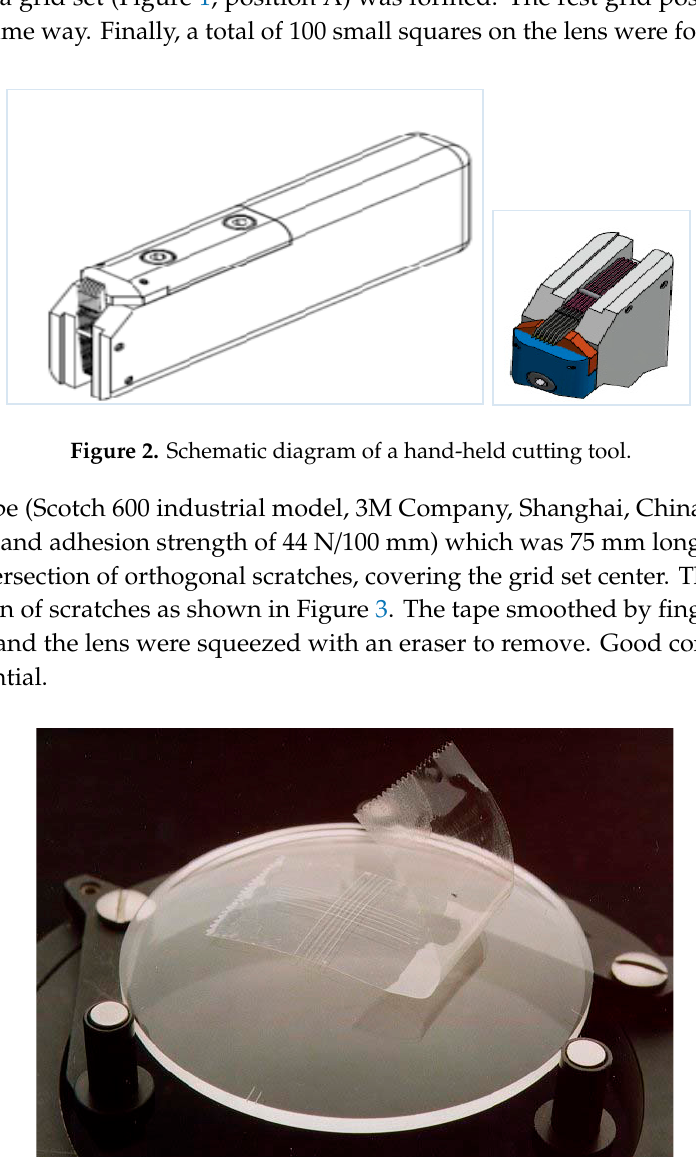
Figure 3. Schematic diagram of well contact between tape and lens.